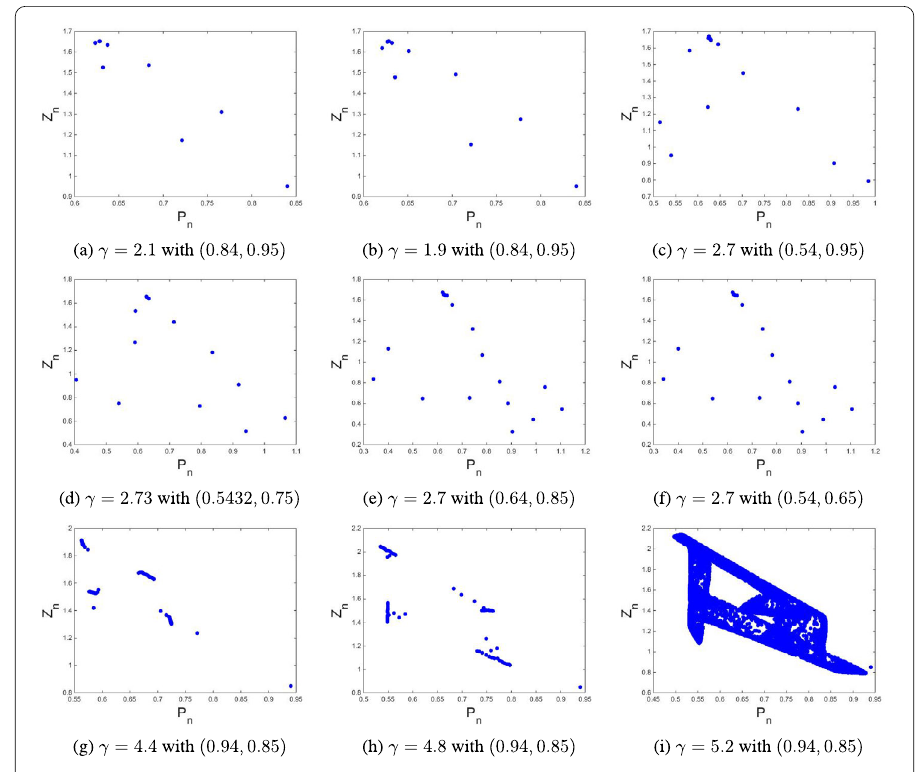
(cid:5) ων 2 ( , PZ 1– ω